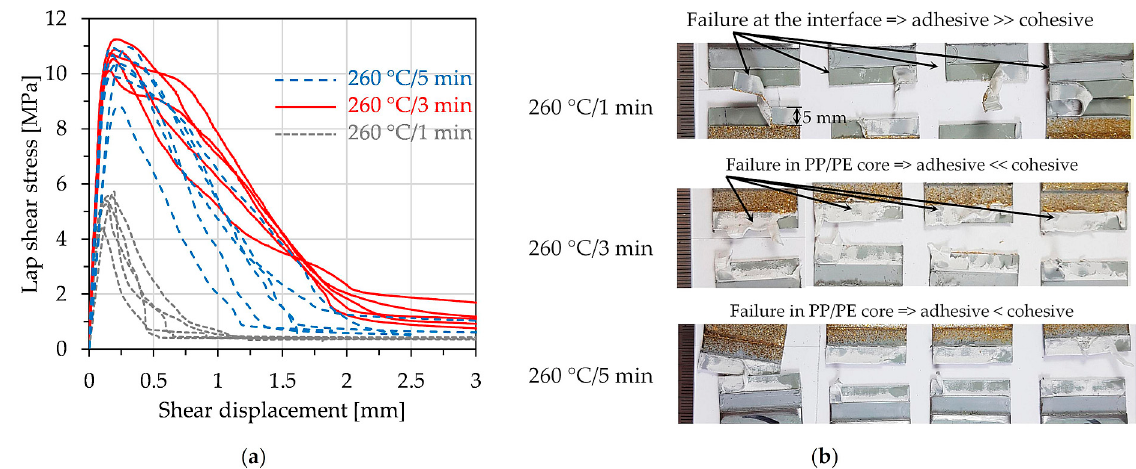
Figure 1. ( a ) Exemplarily representation of the effect of the holding time on the adhesion strength at T = 260 °C for three curing times (1, 3, and 5 min) and ( b ) failure images after the lap shear test showing the cohesive and adhesive failure fractions.